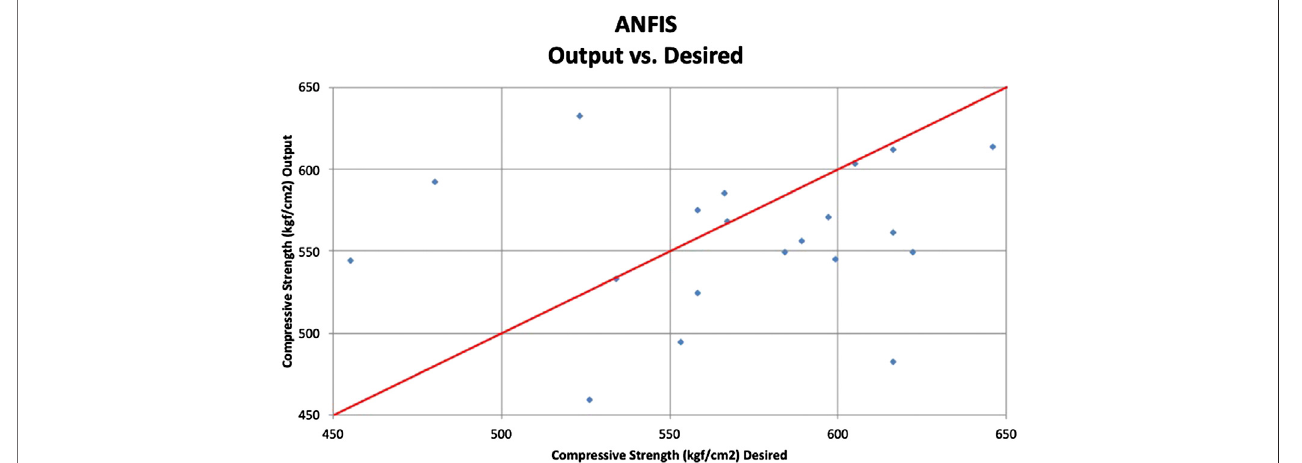
FIGURE 17 | ANFIS model scatterplot